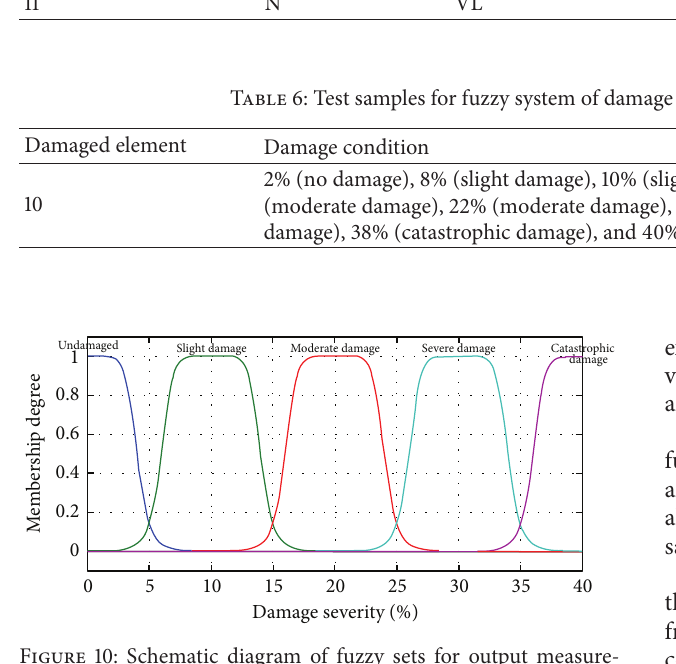
Figure 10: Schematic diagram of fuzzy sets for output measure-